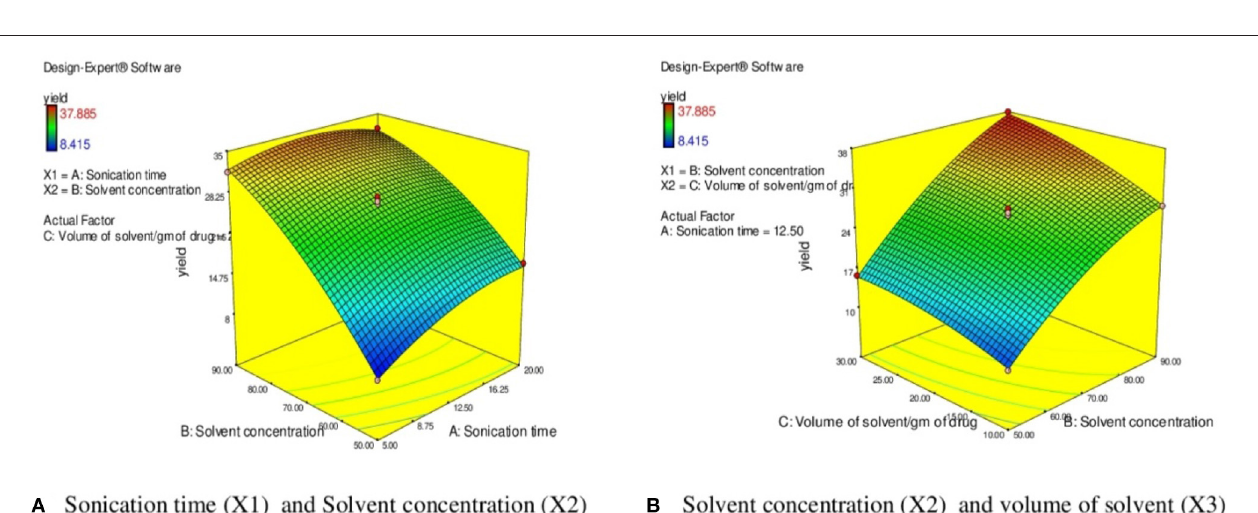
FIGURE 4 | Diagnostic plots to confirm the fitness of developed model in UAE (A) normal plot of residual (B) predicted vs. actual value.